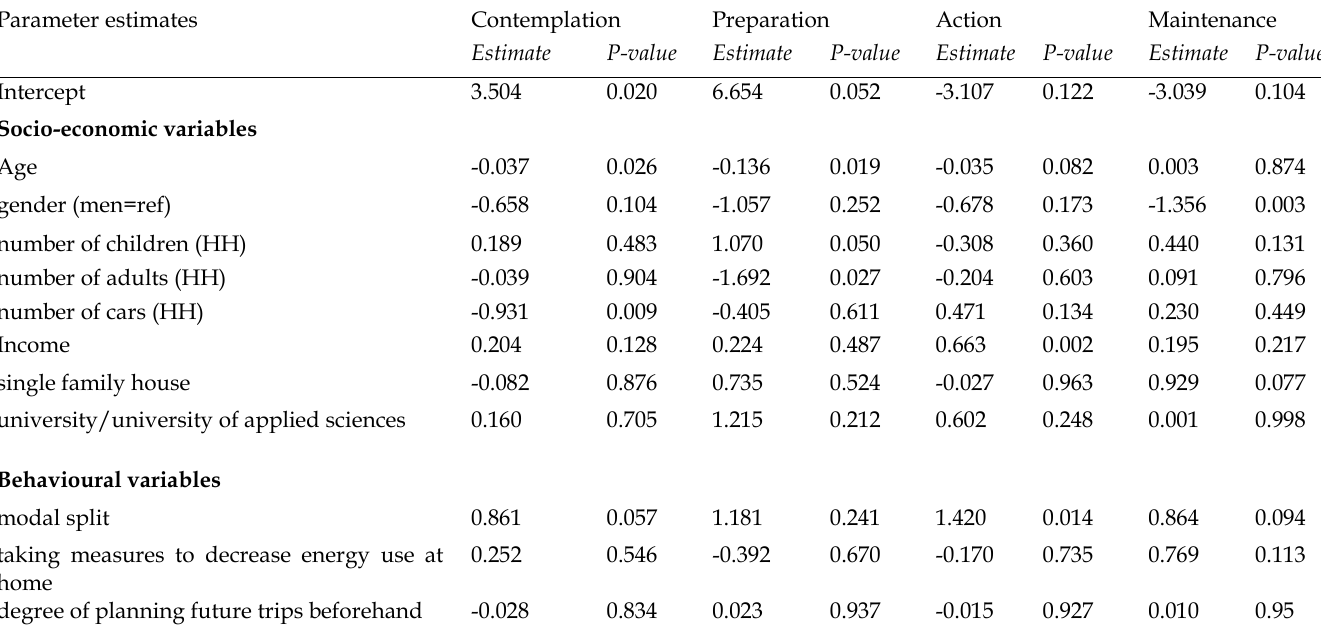
Table 3. Output model 2: MNL-model stage-of-change without socio-cognitive